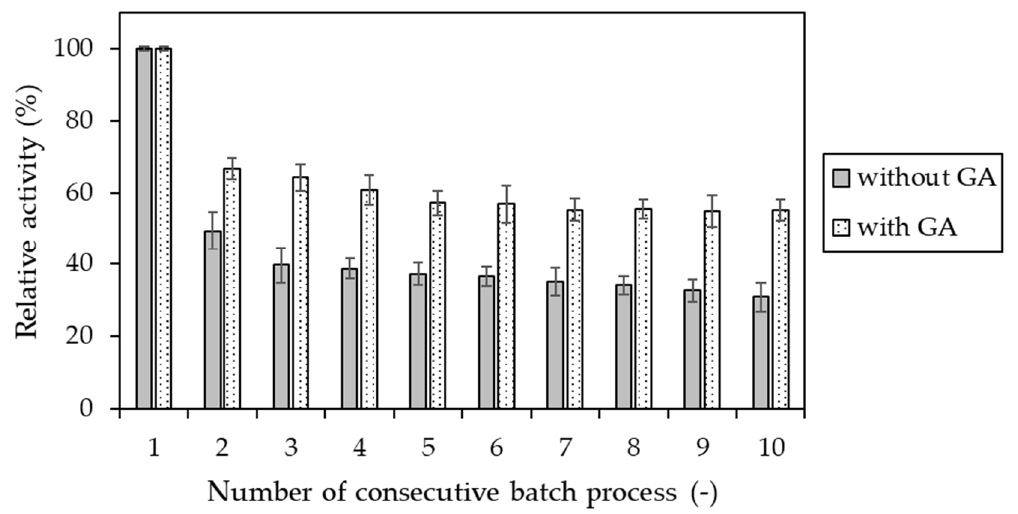
Figure 6. Relative activity of invertase immobilized in alginate-based hydrogel determined after each of 10 consecutive batch processes. Enzyme entrapped without (gray) and with (dotted) additional step of cross-linking with glutaraldehyde (GA). The value of activity obtained in the first reaction cycle was assumed as 100%.